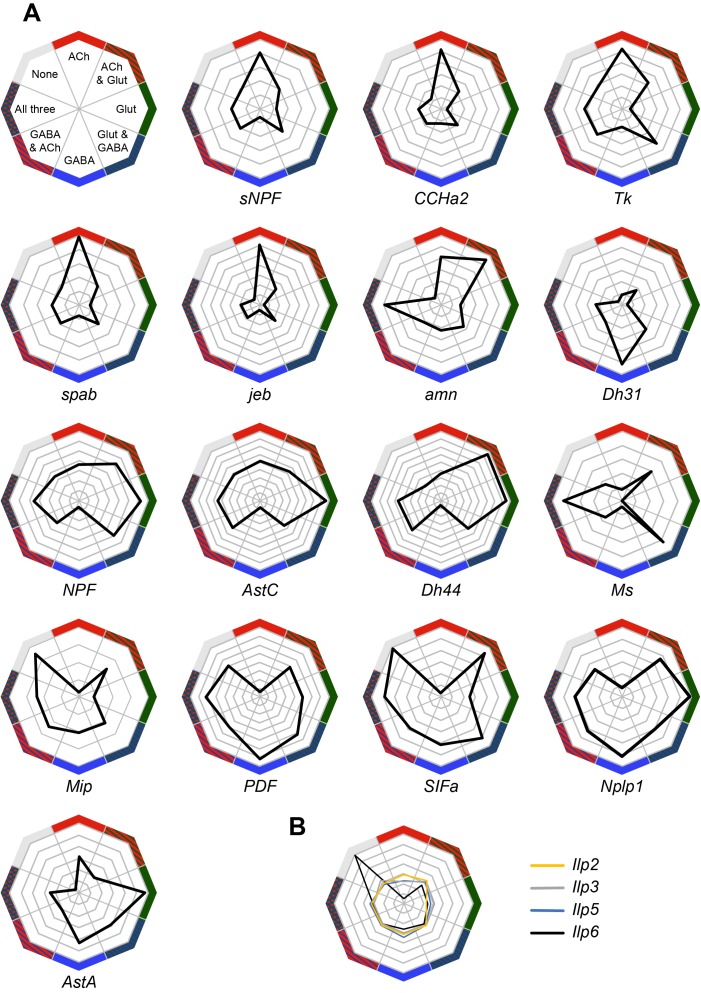
Co-expression of neuropeptides with fast-acting neurotransmitters.(A) Radar plots showing the co-expression of 16 neuropeptides with the three fast-acting neurotransmitters. Data represents the relative abundance of cells expressing a neuropeptide and either VAChT (ACh), VGlut (Glut), Gad1 (GABA), combinations of these three genes, or none of them. (B) Co-expression of four insulin-like peptides, including the non-neuronal Ilp6, with fast-acting neurotransmitters.